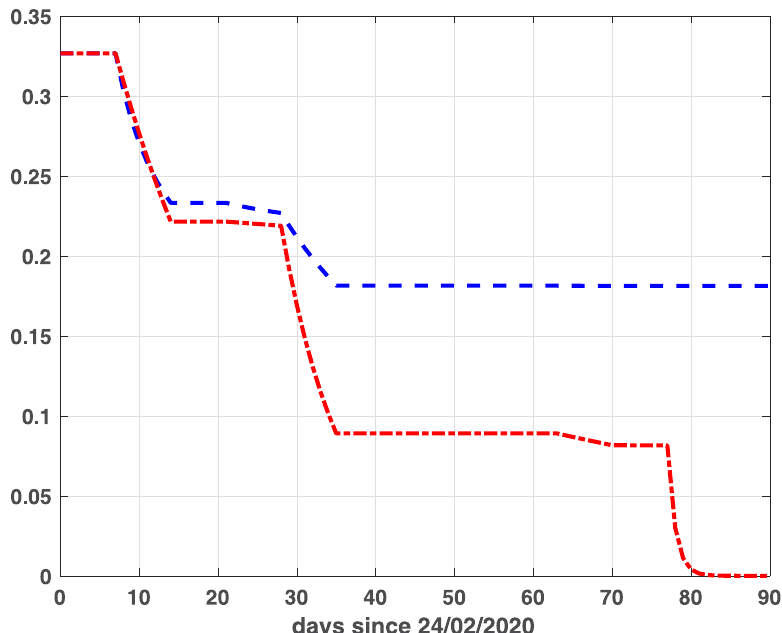
Fig 9. Infection rate in Emilia-Romagna. Functions β r ( t ) (blue dashed line), β e ( t ) (red dash-dotted line), obtained by fSEIRDr and fSEIDRe respectively.